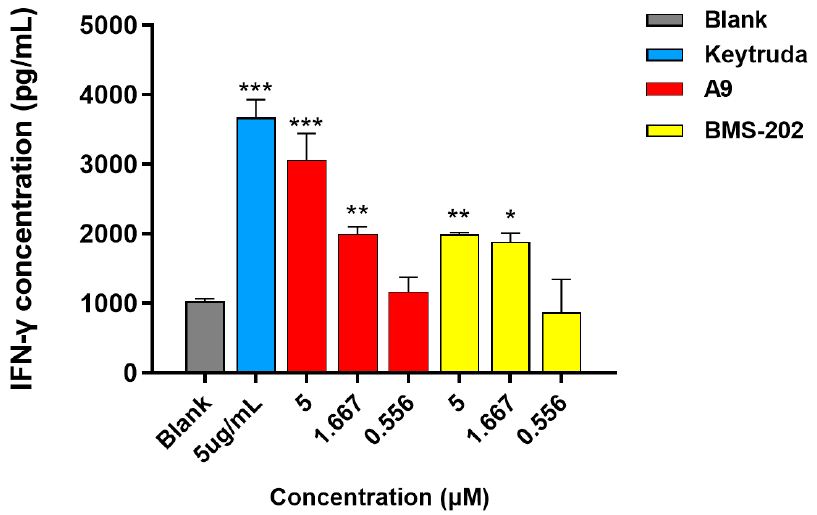
Figure 6. Effects of A9 on IFN- γ expression in a Hep3B/OS-8/hPD-L1 and CD3 + T-cell co-culture assay. A9 and BMS-202, and three independent experiments for blank and Keytruda. Data are shown as mean ± SD ( A9 and BMS-202: n = 2; Blank and Keytruda: n = 3), * p < 0.05, ** p < 0.01, *** p < 0.001 vs. blank group.